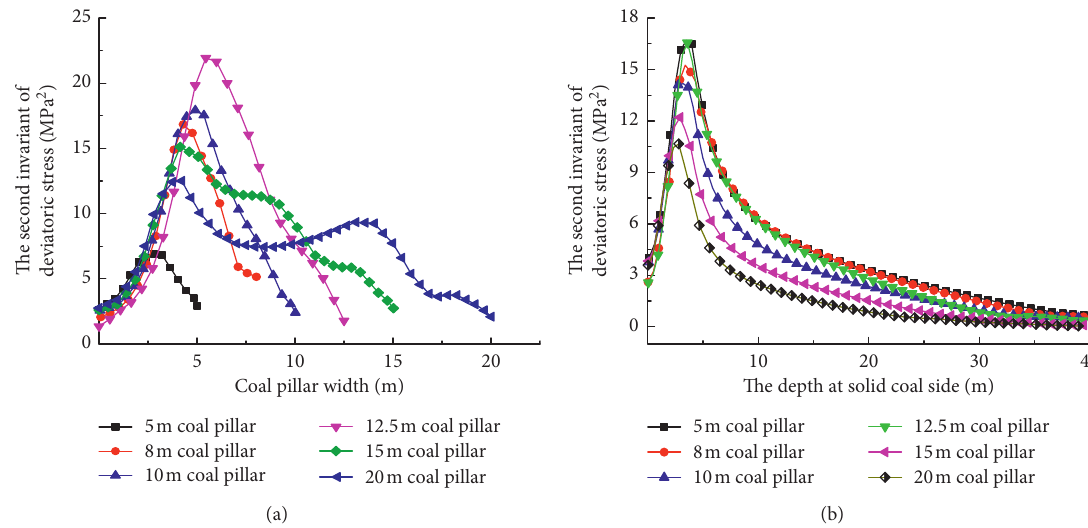
Figure 6: The second invariant of deviatoric stress distribution curves in the two coal girders of the roadway under different width coal pillars. (a) Coal pillar side. (b) Solid coal